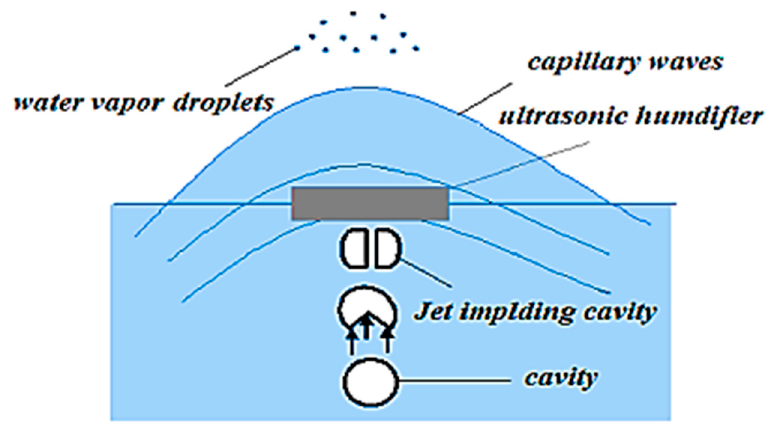
Figure 1. A simple schematic diagram shows the working principle of an ultrasonic atomizer.